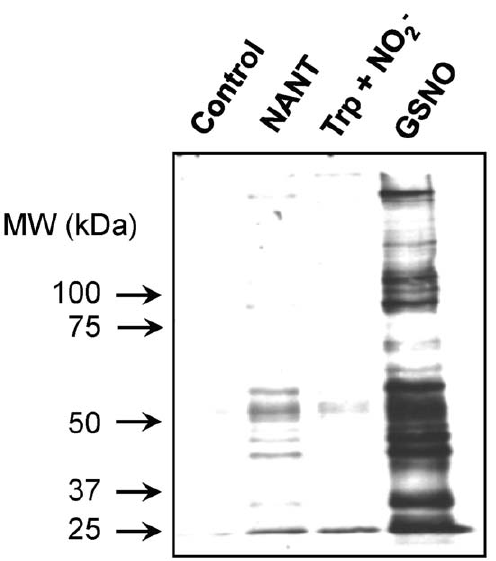
Figure 10. Transfer of NO between nitroso- N -acetyl-Trp and proteins. Cell lysates obtained from murine fibroblasts were incubated alone (Control), with 10 m M nitroso- N -acetyl-Trp (NOTrp), 10 m M sodium nitrite and N -acetyl-Trp (Trp + NO 2 2 ), or 10 m M GSNO (GSNO) for 1 hr at 37 u C. Nitrosated proteins were then determined using the biotin switch assay as described under Materials and Methods. Equal loading was verified using Coomassie blue staining. The immunoblot is represen- tative of three experiments.